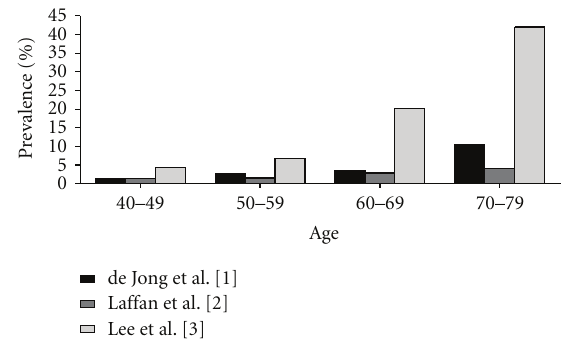
Figure 1: Prevalence of pancreatic cysts in relation to increasing